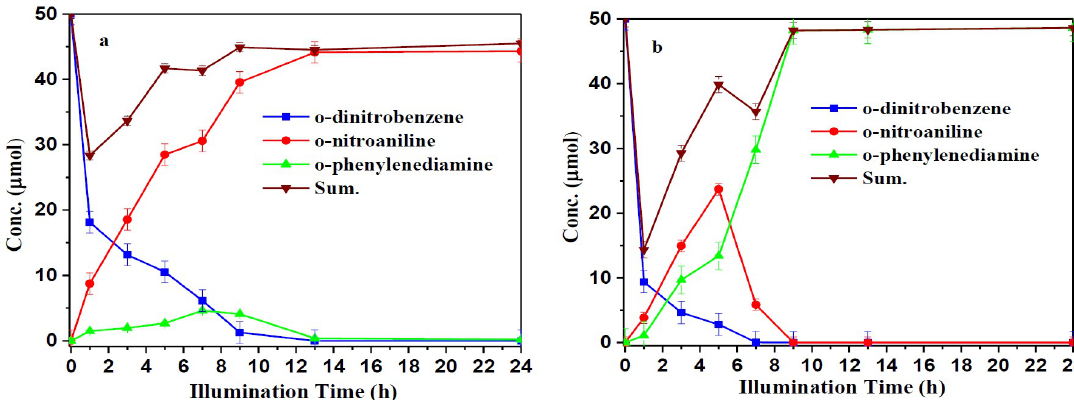
Figure 1. Time-dependent change in the concentration of substrate and products in aqueous solution of ( a ) un-doped TiO 2 (T sample) Note Conc.: Concentration and ( b ) (C, N, S) -doped TiO 2 (DT sample) in the presence of oxalic acid as hole scavenger during photoirradiation under simulated solar light, Note Conc.: Concentration and reaction conditions: 25 mg TiO 2 samples, 50 µmol o-dinitrobenzene, 250 µmol oxalic acid, 5 cm 3 deionized water, Ar.